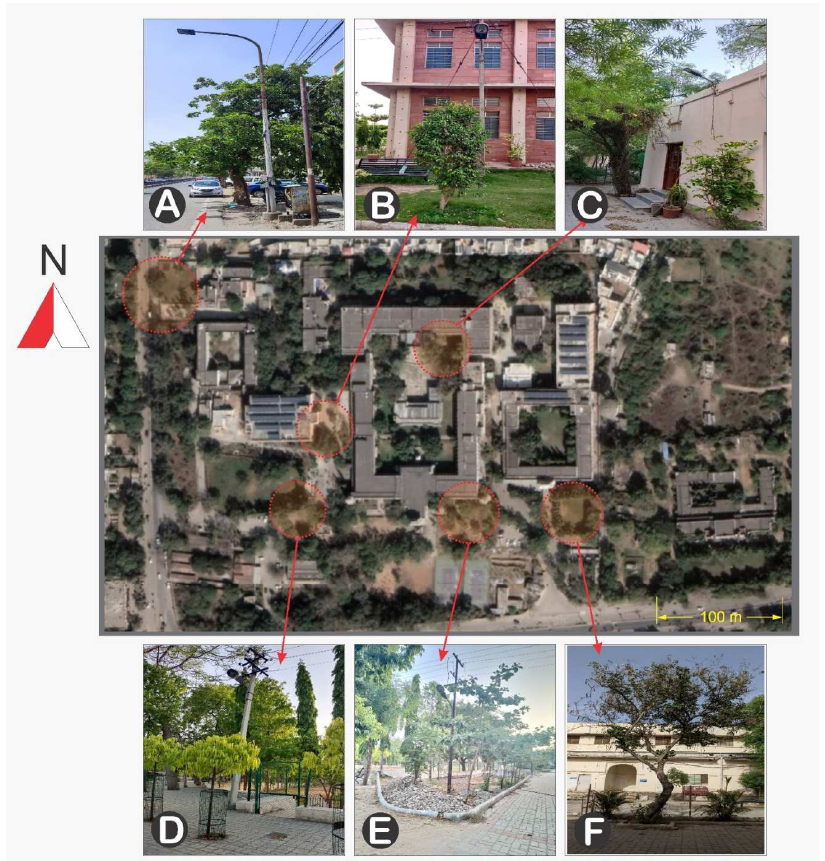
Figure 4. Photographs of six species grown at the study site, university area, Udaipur. Study site (Image source: Google Maps; https://earth.google.com/web/, accessed on 12 August 2021 ); S. asoca ( A ) , T. catappa ( B ) , B. variegata ( C ) , H. integrifolia ( D ) , F. benjamina ( E ) and T. peruviana ( F )